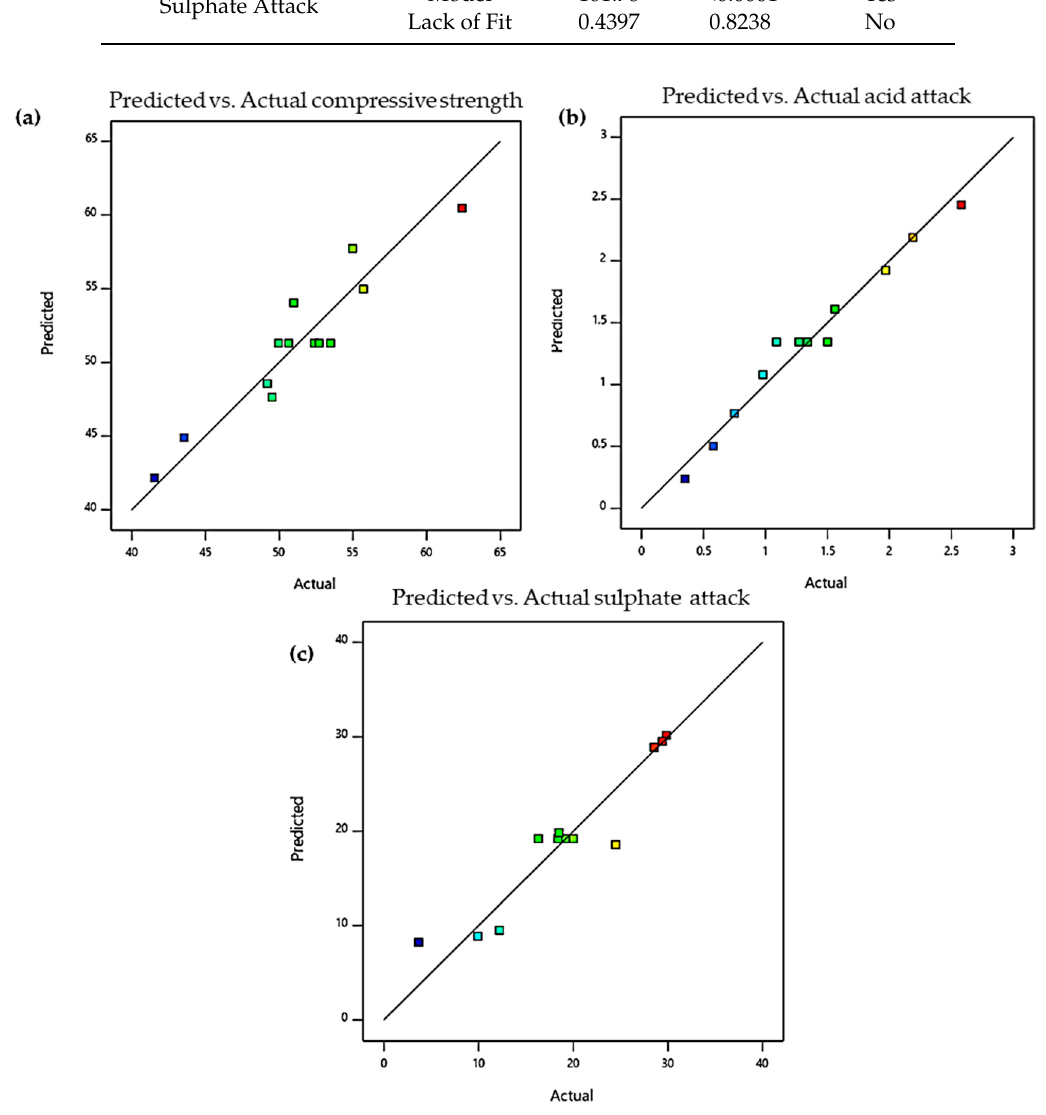
Figure 12. Normality plot of residuals for ( a ) compressive strength, ( b ) acid attack, and ( c ) sulphate attack.